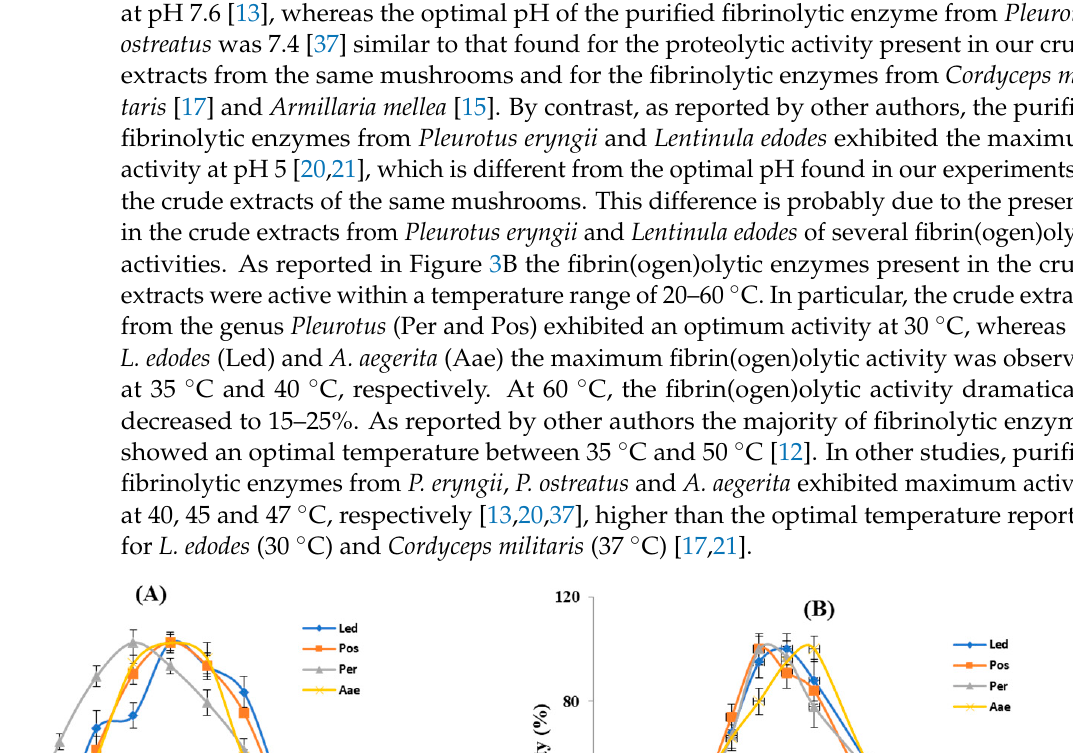
Table 3. Effect of protease inhibitors on fibrin(ogen)olytic enzymes of crude extracts. Residual Enzymatic Activity (%)